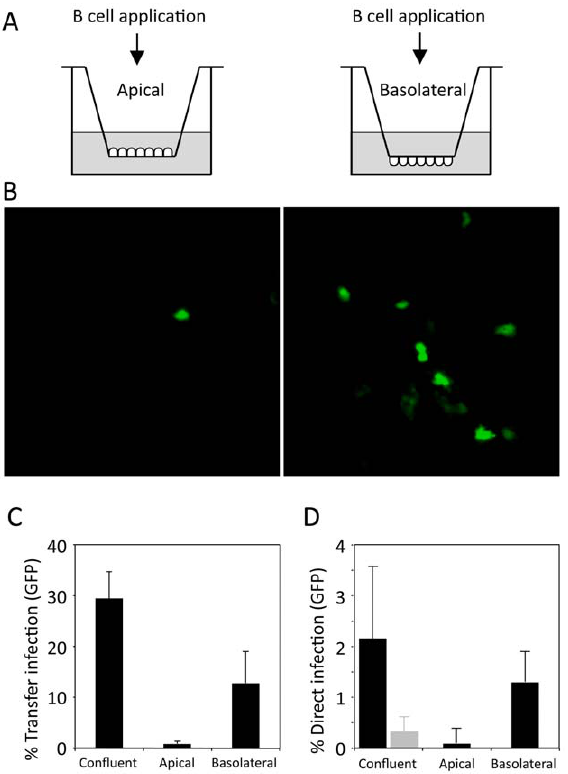
Figure 5. Transfer infection of polarised epithelial cells. (A) Primary tonsillar epithelial cells were grown until polarized on 8 m m pore-size Transwell inserts, as illustrated, to allow access to the apical or basolateral surface of the epithelial cells by B cells. (B) EBV- infected B cells were added to either surface for 4 hours, then washed off and epithelial cell infection observed after 24 hours by GFP- expression. (C) Epithelial cell infection (GFP) was quantitated by flow cytometry of . 10,000 cells. The % transfer infection (mean of triplicates) was plotted for confluent (unpolarized) cells and compared to transfer infection from the apical and basolateral surfaces. (D) Direct epithelial cell infection with the gp350-deleted virus. Infection (GFP) was quantitated by flow cytometry of . 10,000 cells. The % of direct infection (mean of triplicates) for confluent (unpolarized) cells was compared to direct infection from the apical and basolateral surfaces. The gp350-restored virus is also shown (grey bar). doi:10.1371/journal.ppat.1001338.g005 (Figure 4C), contains side-chains modified by heparan sulphate moieties [25]. We therefore asked whether heparan sulphate, as it did with unpolarized monolayer cultures (Figure 3B), played a role in transfer infection via the basolateral surface. Virus-loaded B cells were preincubated with 32 m g/ml of heparan sulphate, chondroitin sulphate or hyaluronic acid in binding buffer for 1 hour at 37 u C before co-culture with the epithelial basolateral surface. The epithelial cells were analysed for GFP expression after 24 hours and, as shown in Figure 6B, heparan sulphate inhibited transfer infection by up to 55% whilst the control GAGs, chondroitin and hyaluronic acid, had no effect. Integrins and heparan sulphate side-chains appear to play a significant role in transfer infection via the epithelial basolateral membrane. We therefore examined the effects of blocking antibodies to integrins expressed on epithelial cells and to receptors on B cells that bind heparan sulphate. In each experiment, the virus-loaded B cells and the epithelial cells were pre-incubated with the antibodies for 30 minutes at 4 u C,